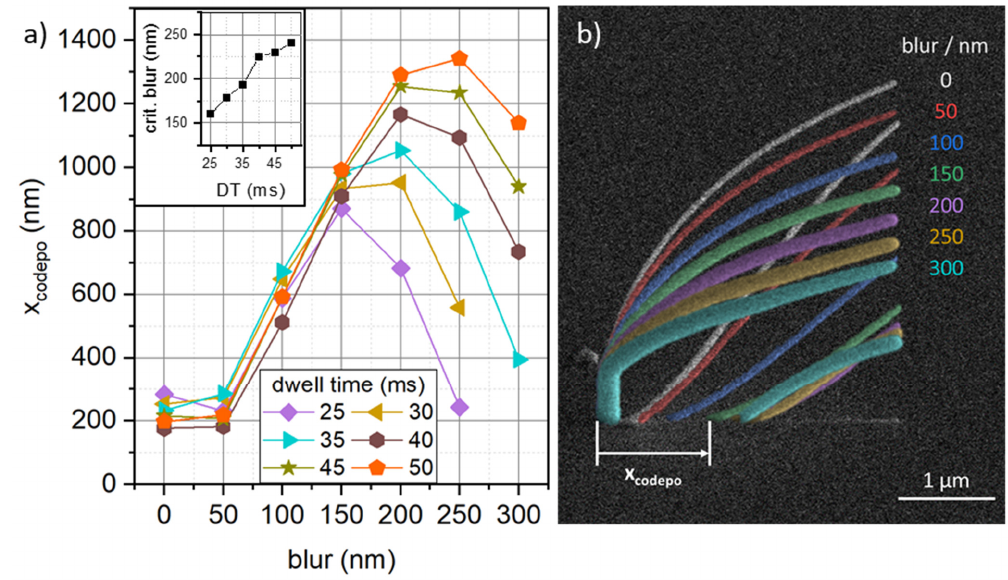
Figure 3. Horizontal distance upon formation of a co-deposit (X codepo ) in dependency of beam blurs for different dwell times (DTs) ( a ) together with a superimposed, in-scale SEM image ( b ), which directly shows the delayed co-deposit by the introduction of beam blurs (grouped by color). The inset in ( a ) gives the DT dependent maxima of X codepo .